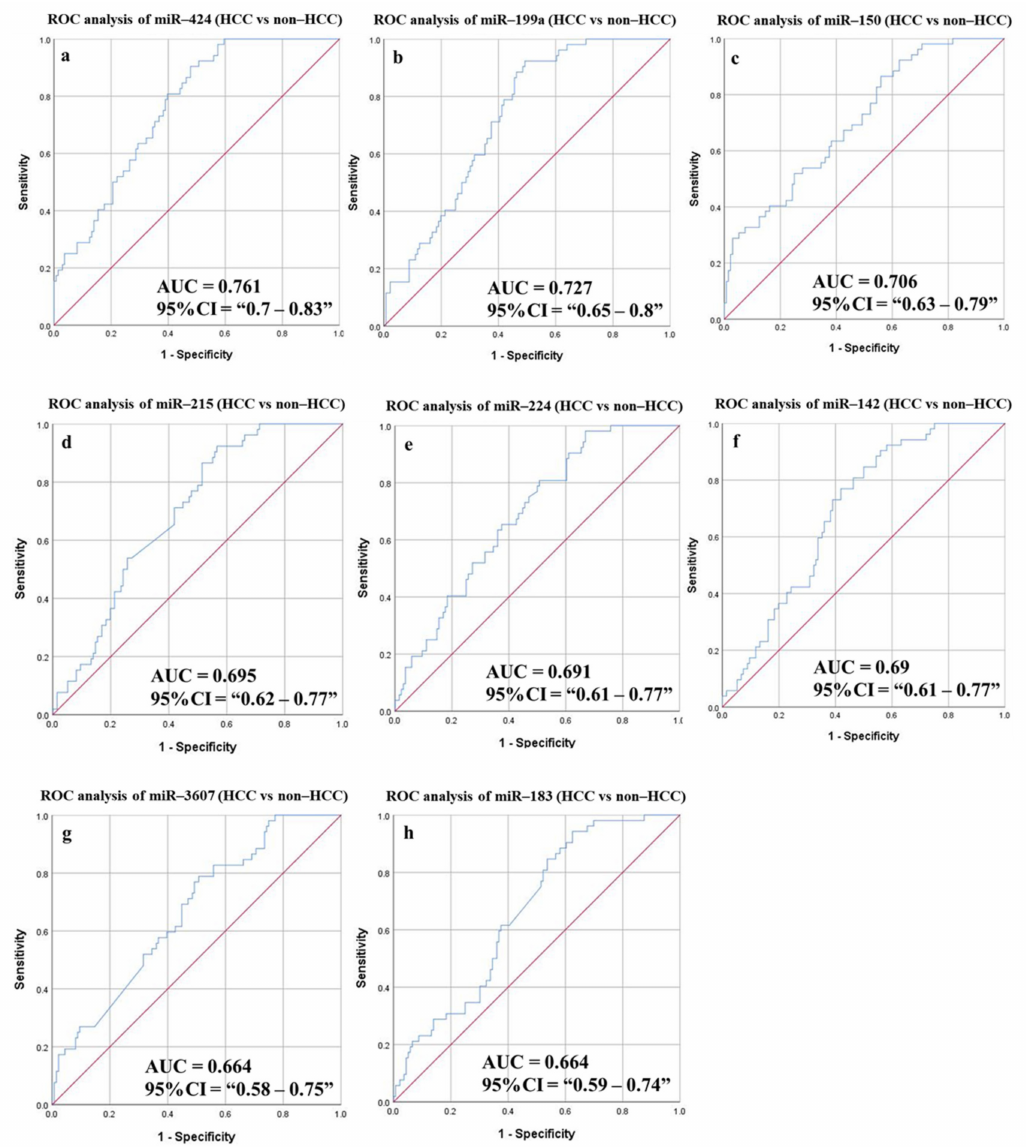
Figure 8. ROC curves and AUC for DE-miRNAs differentiate between HCC patients and non-HCC (healthy controls, non-cirrhotic, and cirrhotic HCV patients). The diagnostic potential and AUC of the eight DE-miRNAs [( a ) miR-424 ( b ) miR-199a ( c ) miR-150 ( d ) miR-215 ( e ) miR-224 ( f ) miR-142 ( g ) miR-3607 and ( h ) miR-183] were calculated. (DE: Differentially expressed, HCC: Hepatocellular carcinoma, ROC: Receiver operating